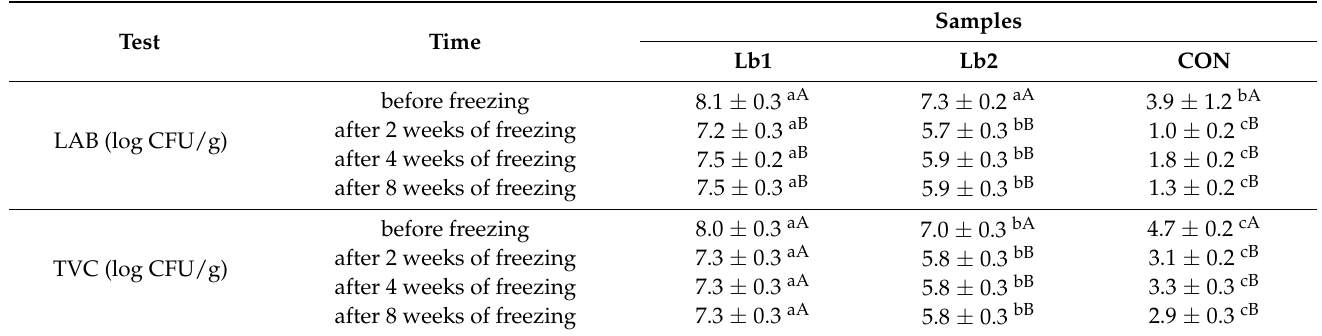
Table 4. Microbial analysis of the non-dairy ice cream dessert during